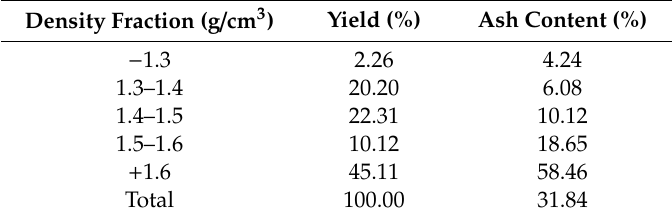
Table 3. Float-sink test results of LRC